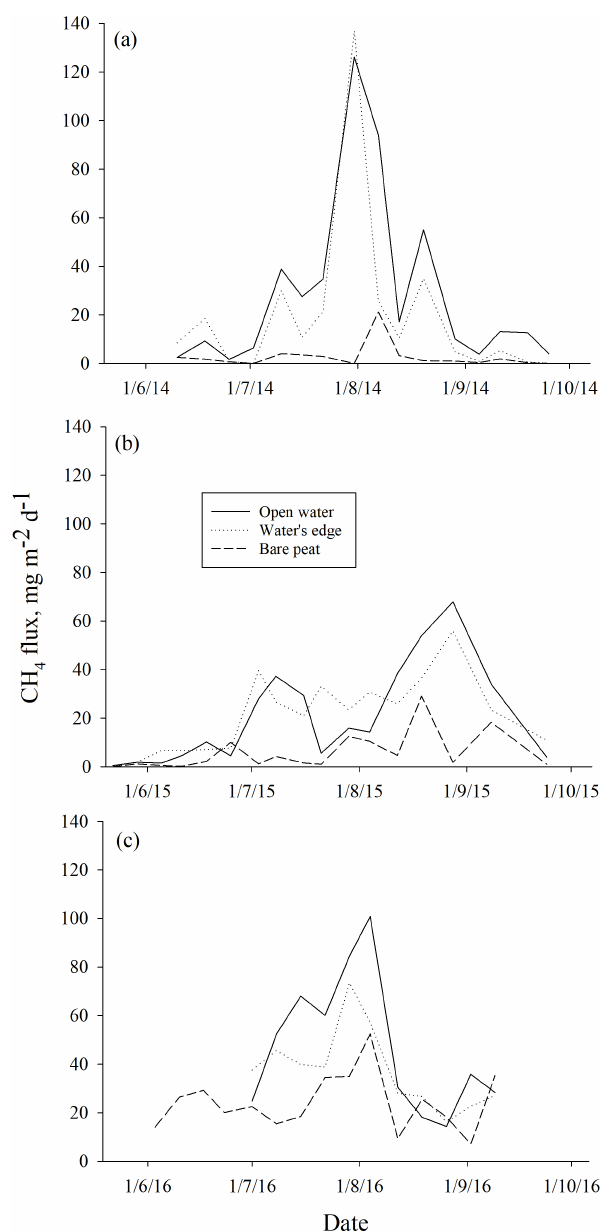
Figure 3. Mean methane ebullition measured weekly in Siikaneva bog over three consecutive years (a) 2014, (b) 2015 and (c) 2016 over different surfaces: bare peat, open water and the water’s